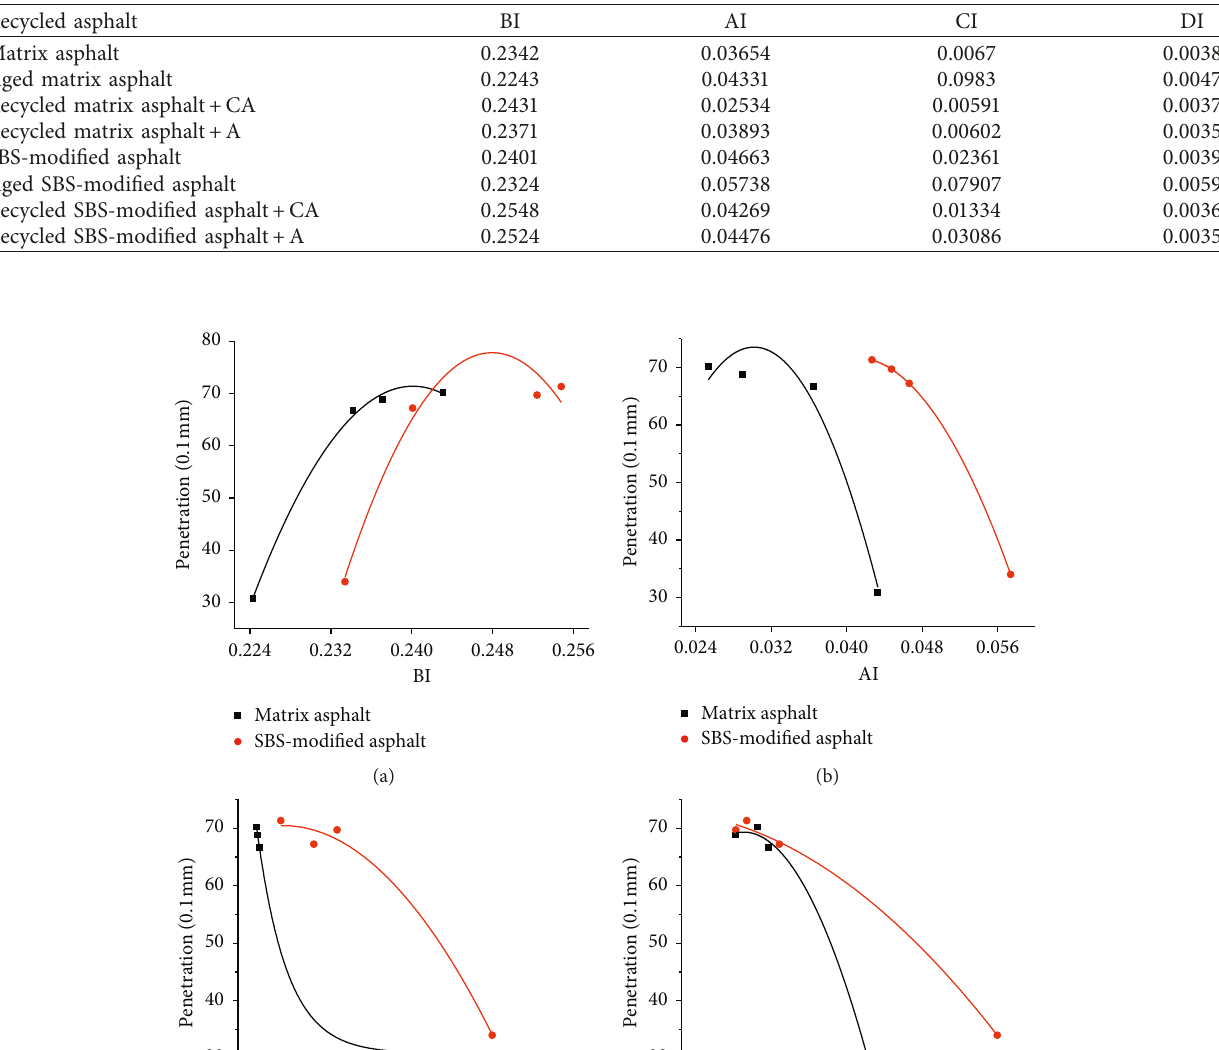
Table 6: Functional group indices for different states of